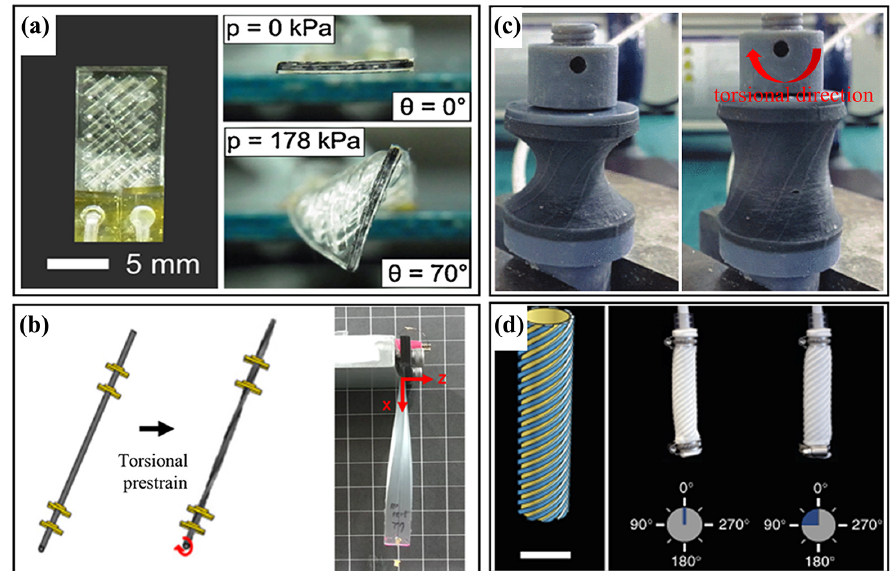
Figure 11. ( a ) Torsional actuator and torsional angles with different pressures [96]. ( b ) Schematic diagram of torsional prestrain and torsional angle of the actuator [99]. ( c ) Process of a pneumatic torsional actuator [101]. ( d ) Model drawing and torsional effect